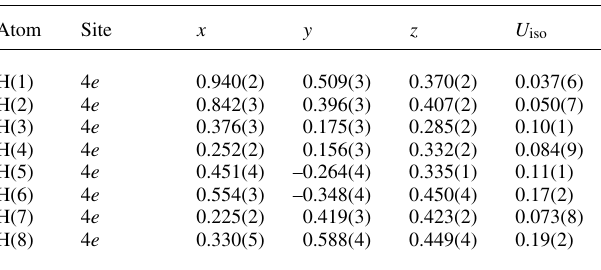
Table 2. Atomic coordinates and displacement parameters (in Å 2 )